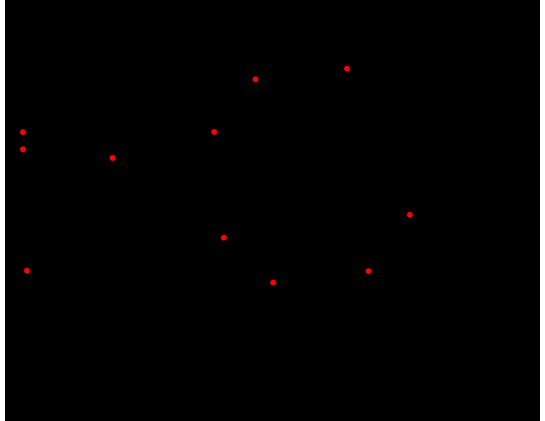
Figure 4. Extraction process of guidance lamp peaks.